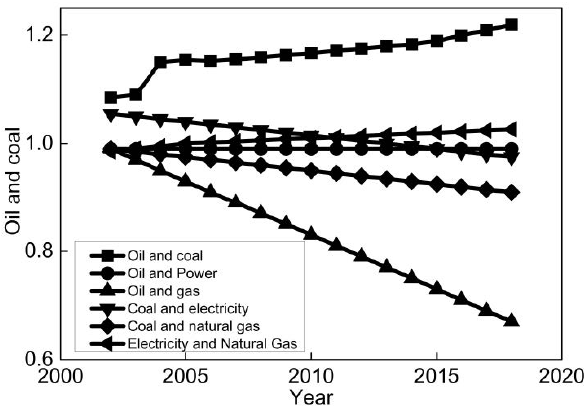
Fig. 6 Alternative elasticity of different energy elements